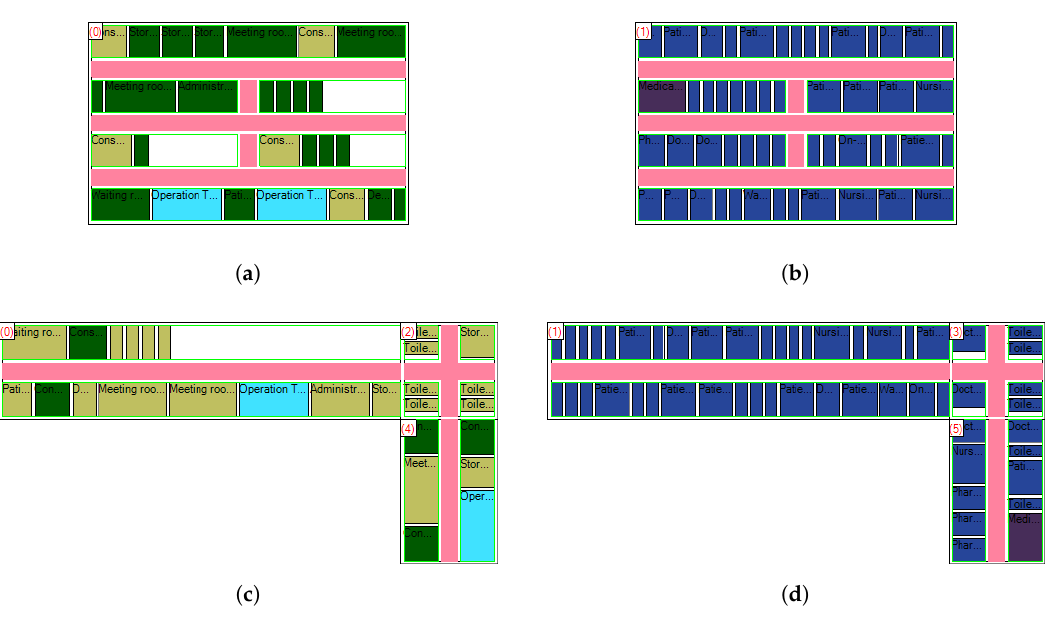
Figure 3. EDC internal model screen shot. ( a ) Alternative 1, Story 0; ( b ) Alternative 1, Story 1; ( c ) Alternative 2, Story 0; ( d ) Alternative 2, Story